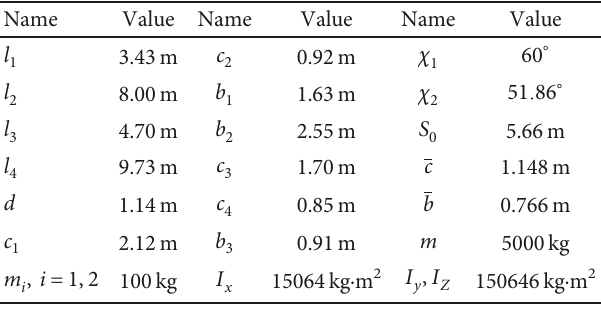
Figure 1: Main outline of a hypersonic morphing missile.